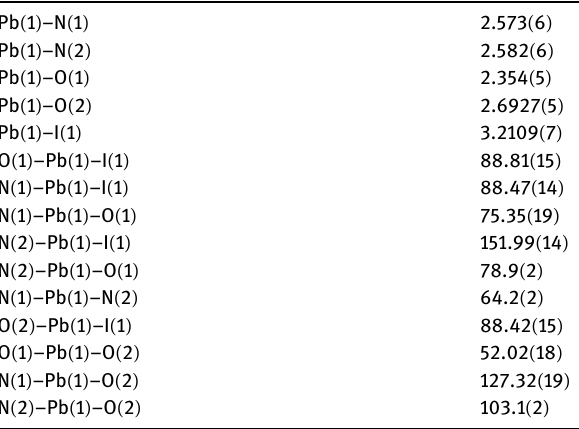
Figure 1: View of the coordination environment of the Pb ( II ) atom of 1 ( symmetric code: ( i ) − x + 1, − y + 1, − z ) .